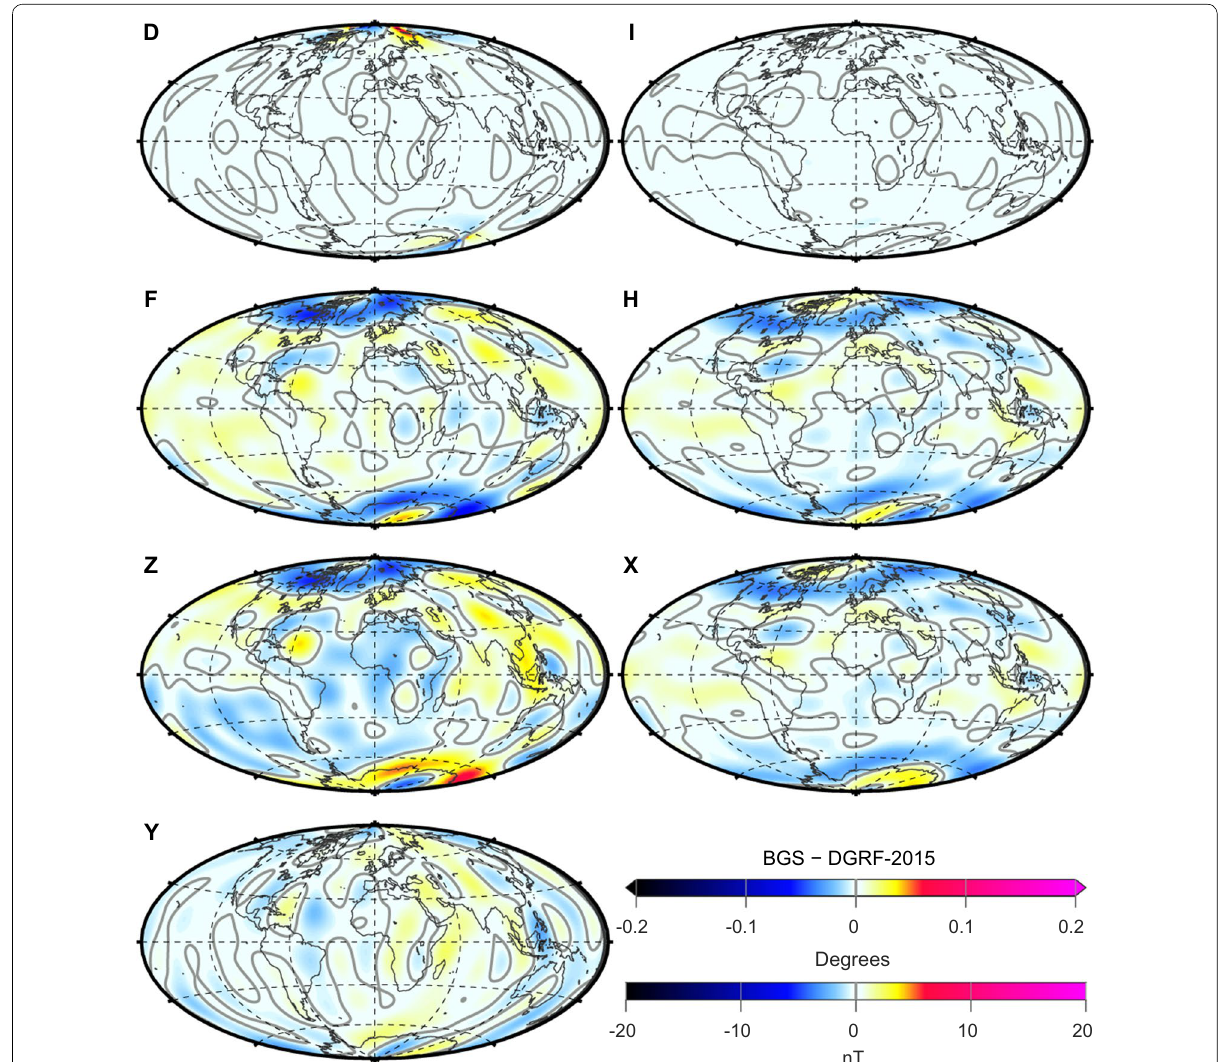
Fig. 5 Difference in each magnetic component between the BGS candidate model for 2015.0 and DGRF-2015 (median of IGRF-13 candidates). Values of contours (grey lines) are marked on the colour scales, with a thicker line for the zero